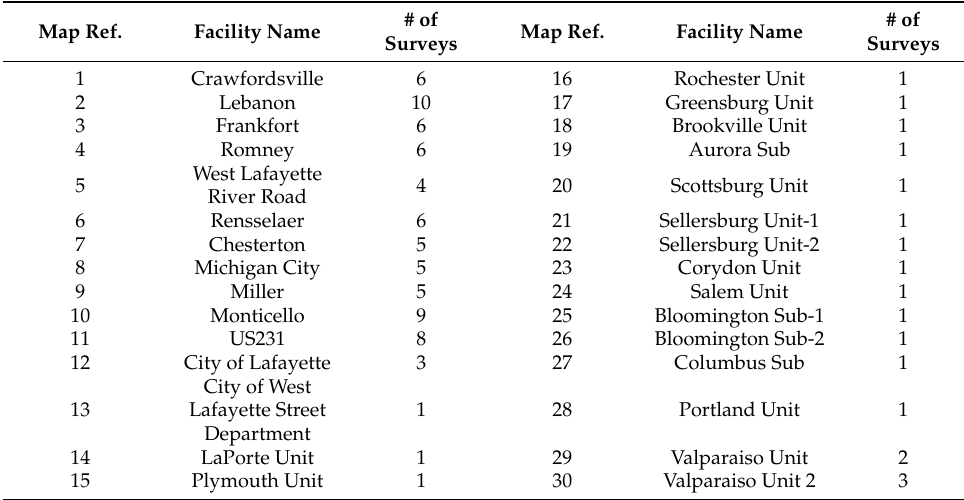
Table 1. Summary of data collections at each facility. Map